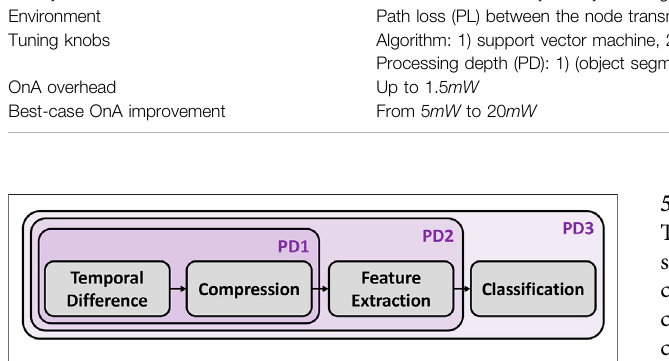
TABLE 2 | Overview of fl exible TKs in the wireless video node Cao et al. (2017). — — Application Video surveillance: Detecting the presence of human beings Quality